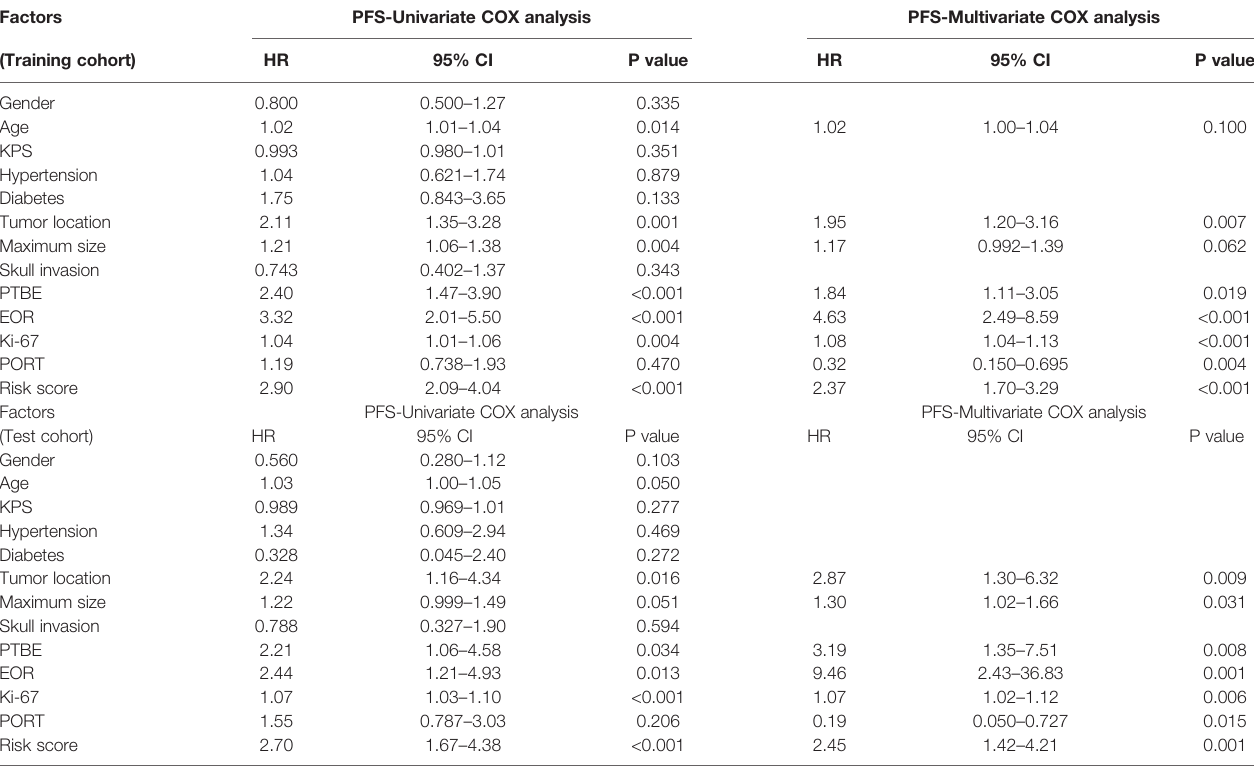
TABLE 3 | Univariate and multivariate COX regression analysis for clinical